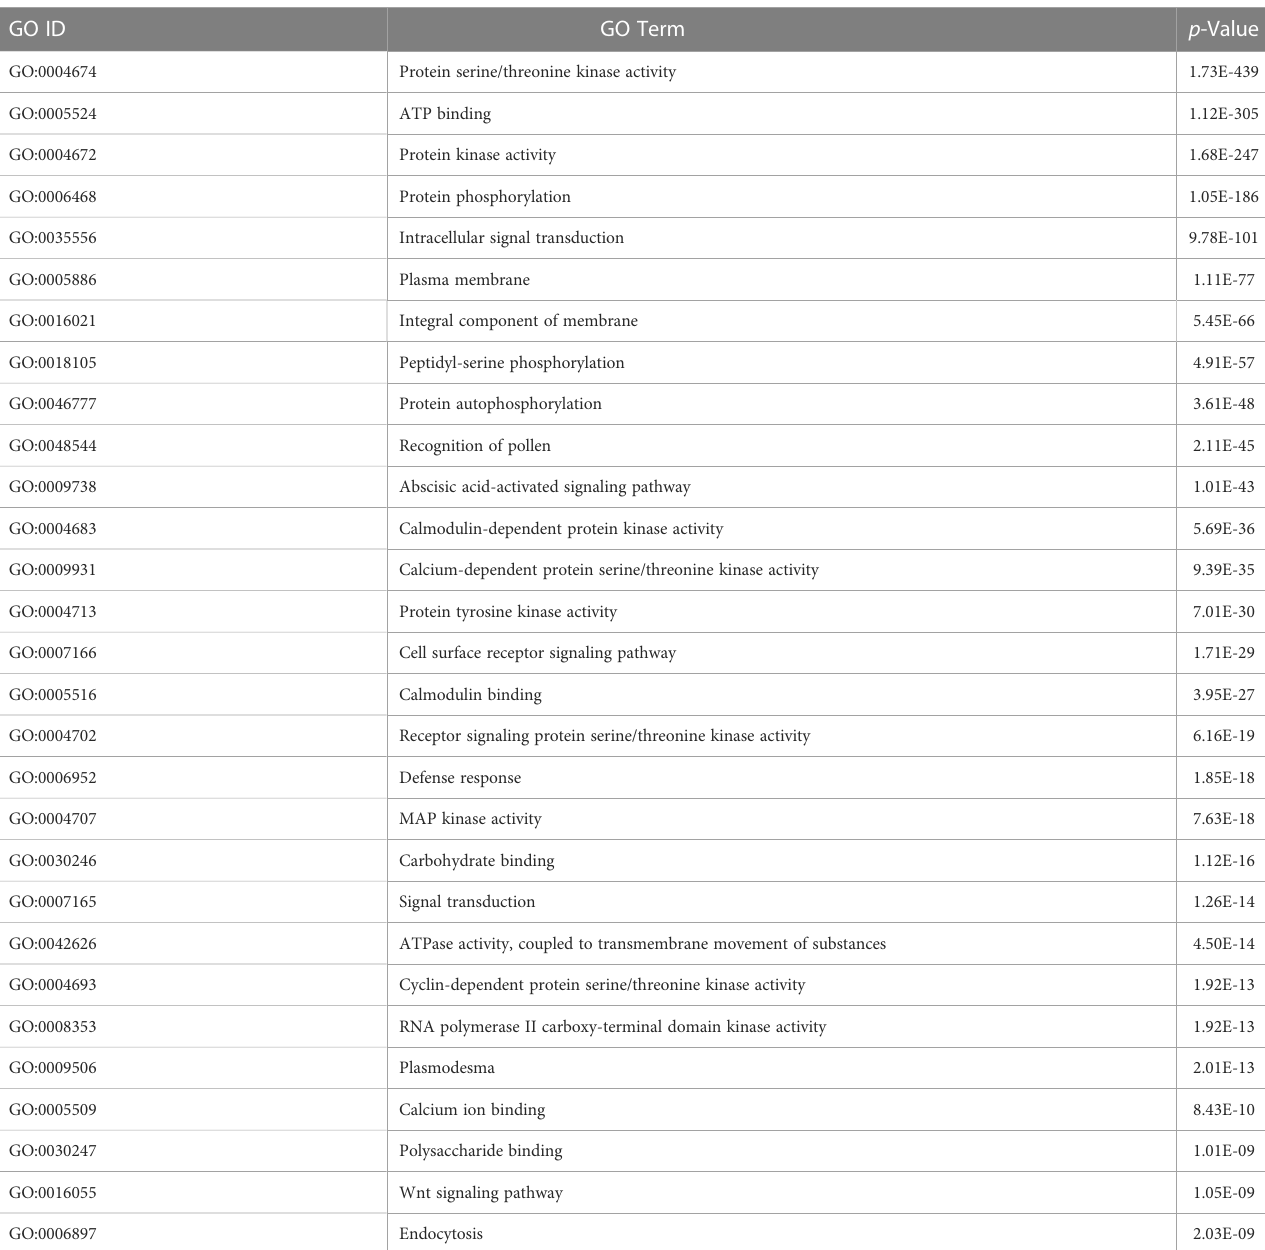
TABLE 3 GO enrichment analysis of predicted rice proteins. GO